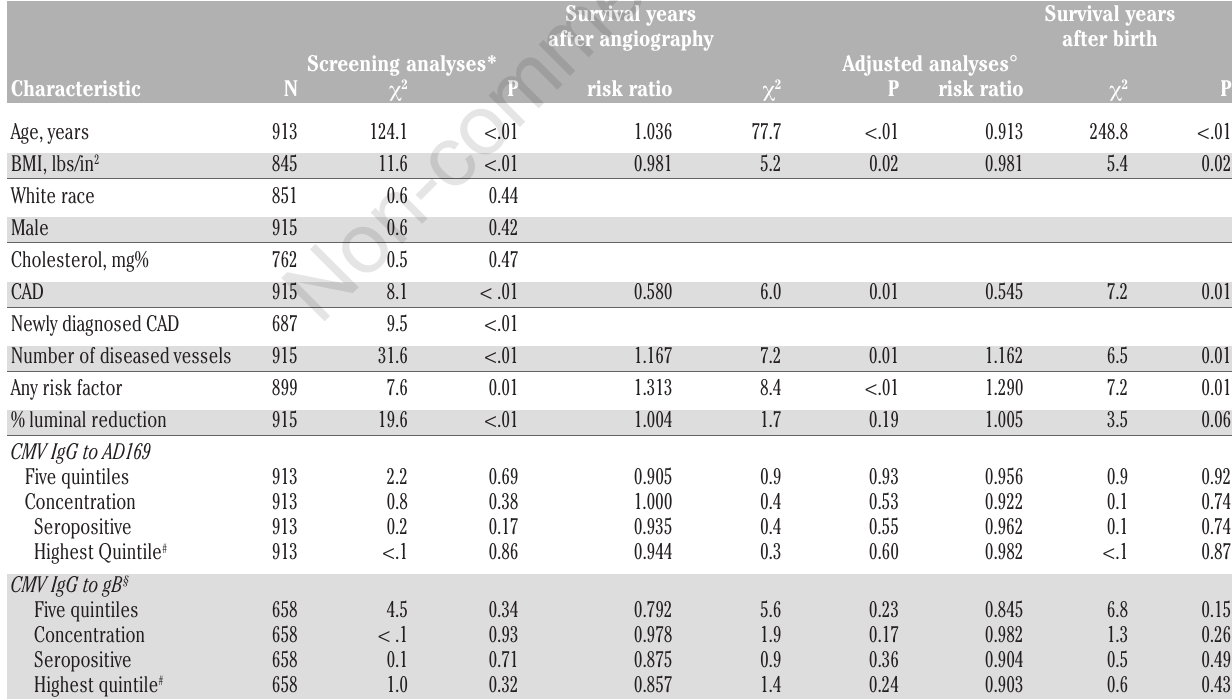
Table 3. Survival analysis of patients by two measures of cytomegalovirus antibody.